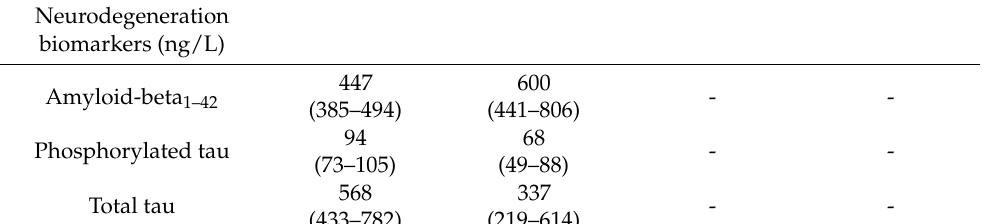
Table 1. Cerebrospinal fluid (CSF) and serum levels of selenoprotein P and CSF levels of selenoprotein-P-bound selenium, amyloid-beta and phosphorylated and total tau in relation to